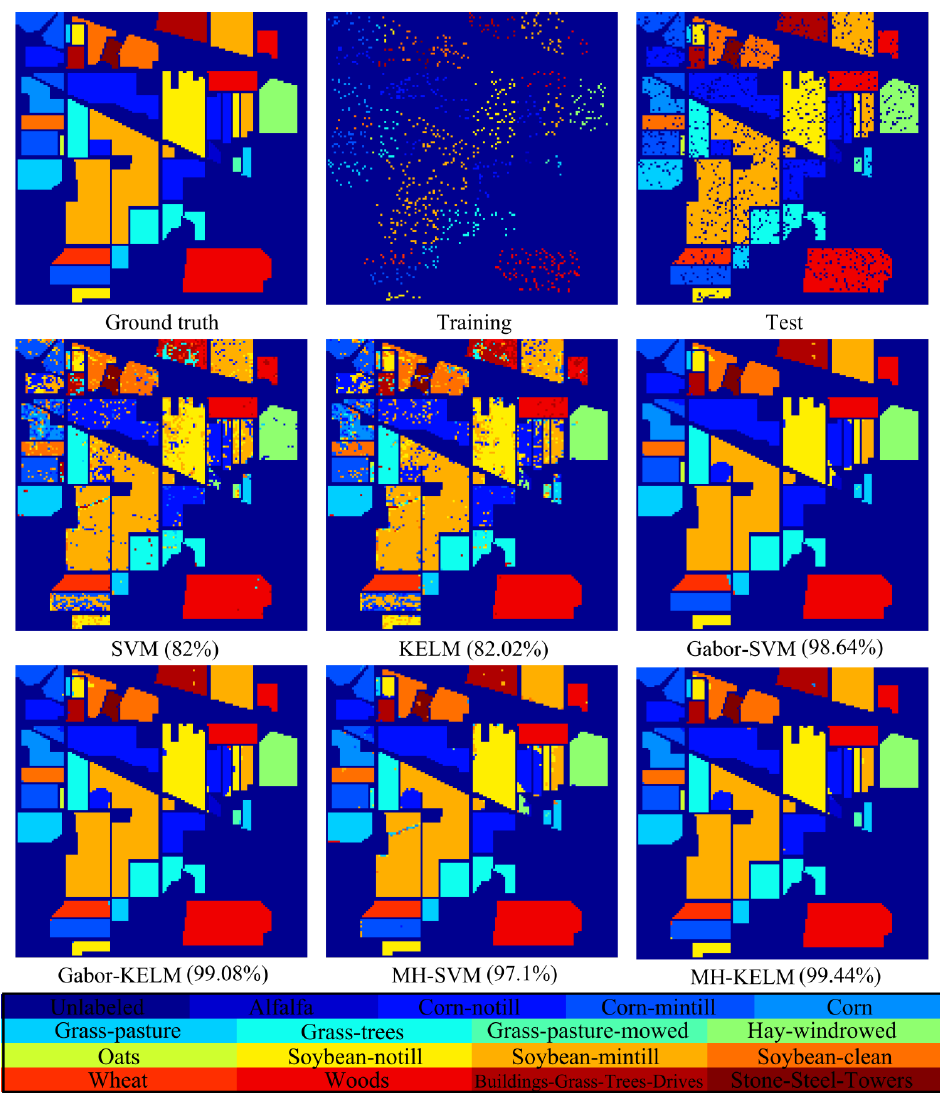
Figure 7. Thematic maps resulting from classification using 1018 training samples (10% per class) for the Indian Pines dataset with 16 classes. The overall classification accuracy of each algorithm is indicated in